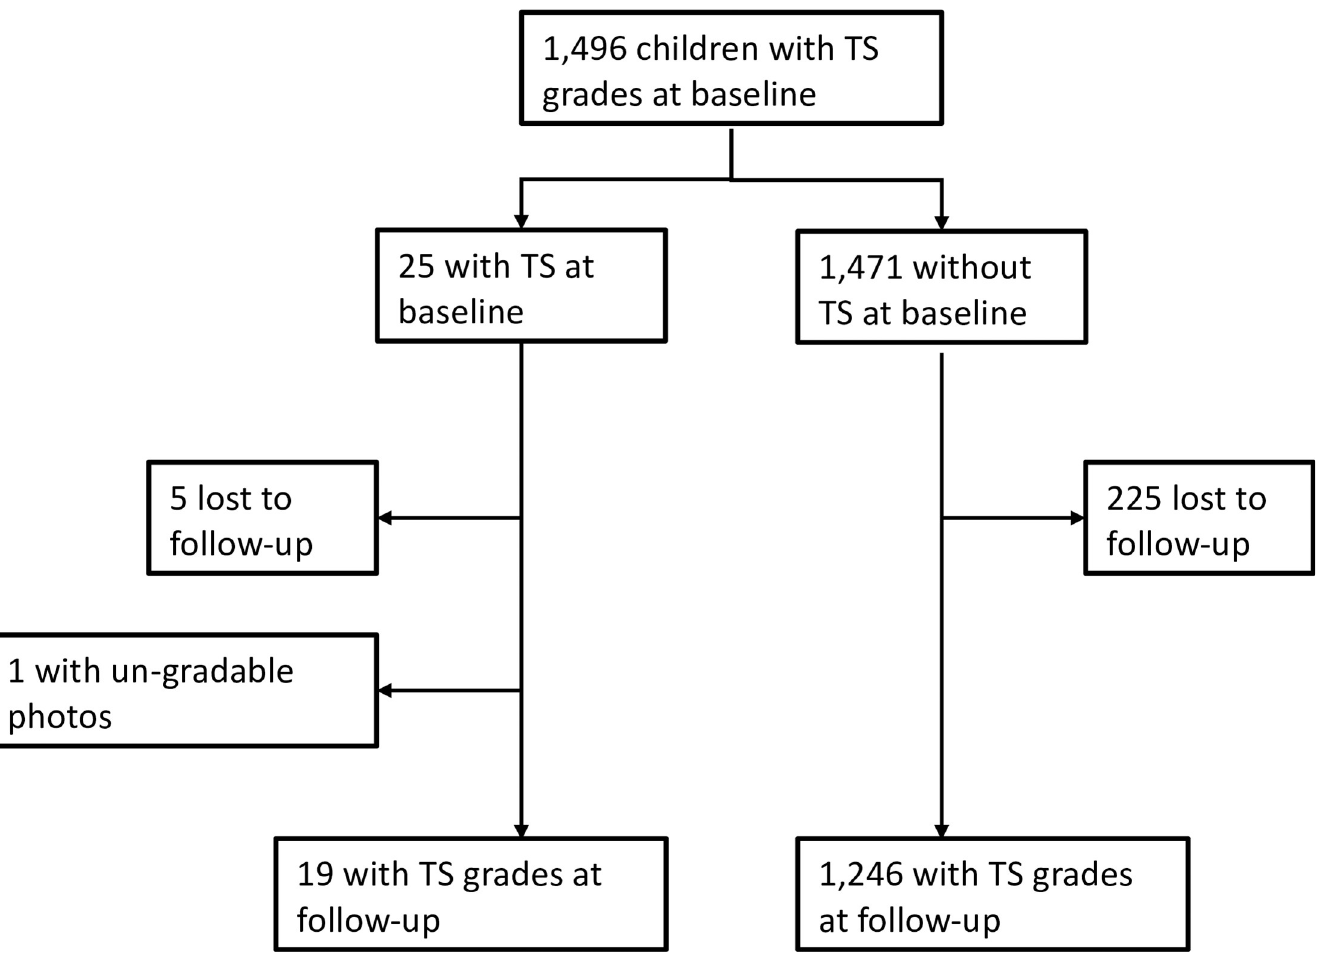
Fig 1. Flowchart describing participant follow-up at 2 years.